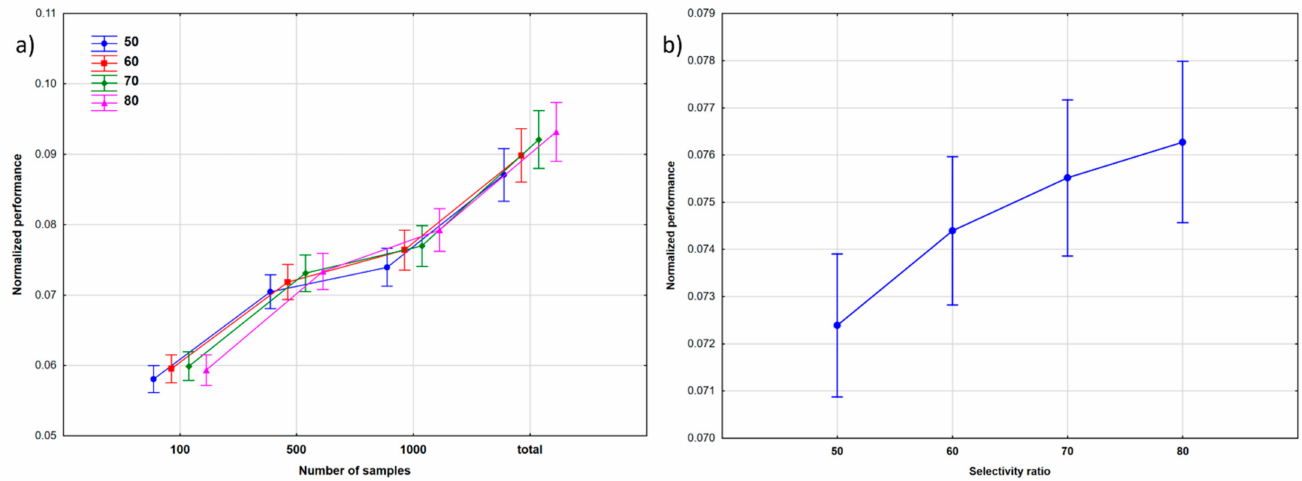
Figure 5. The effect of: ( a ) the number of samples (NS) at different split ratios, and ( b ) the split ratios (SR) on the performance of the models for Case Study